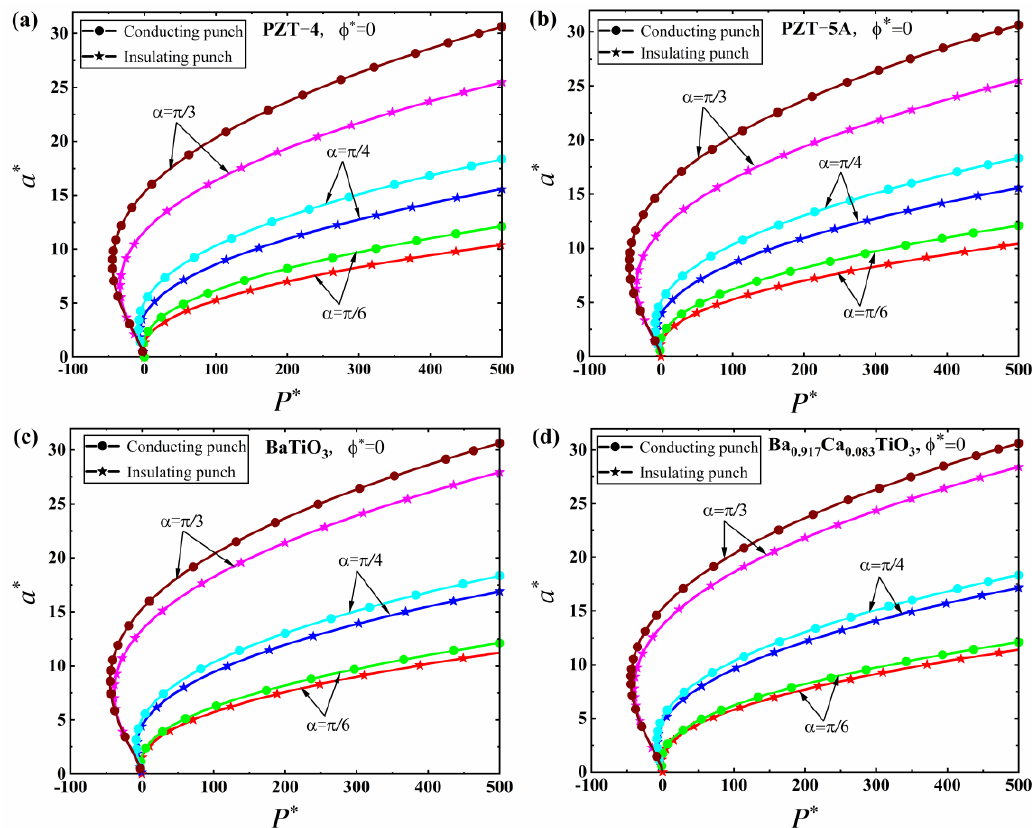
Figure 4. Variation of the dimensionless contact radius, a ∗ , with the dimensionless indentation force, P ∗ , at the different values of α = π /6, π /4 and π /3 for the conducting punch with zero electric potential and insulating punch. ( a ) PZT-4. ( b ) PZT-5A. ( c ) BaTiO 3 . ( d ) Ba 0.917 Ca 0.083 TiO 3 .